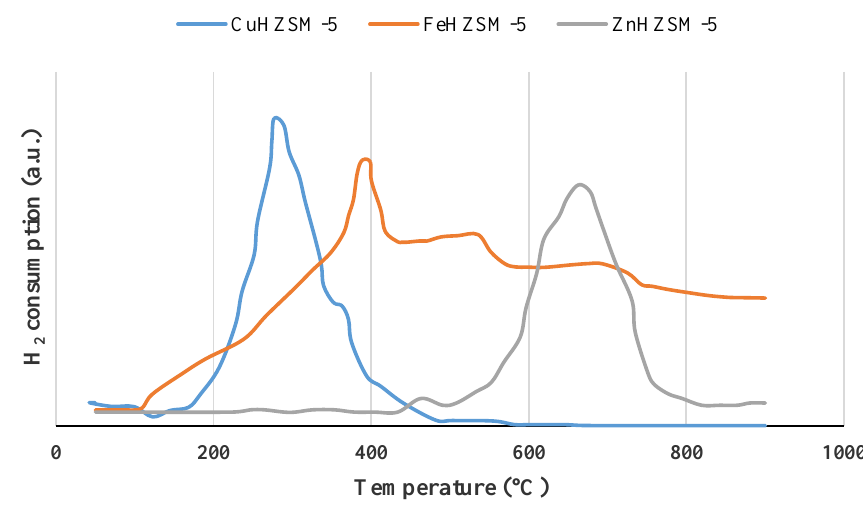
Figure 6. H 2 -TPR profiles for 4 wt. % FeHZSM-5, 4 wt. % CuHZSM-5 and 4 wt. % ZnHZSM-5 catalysts.